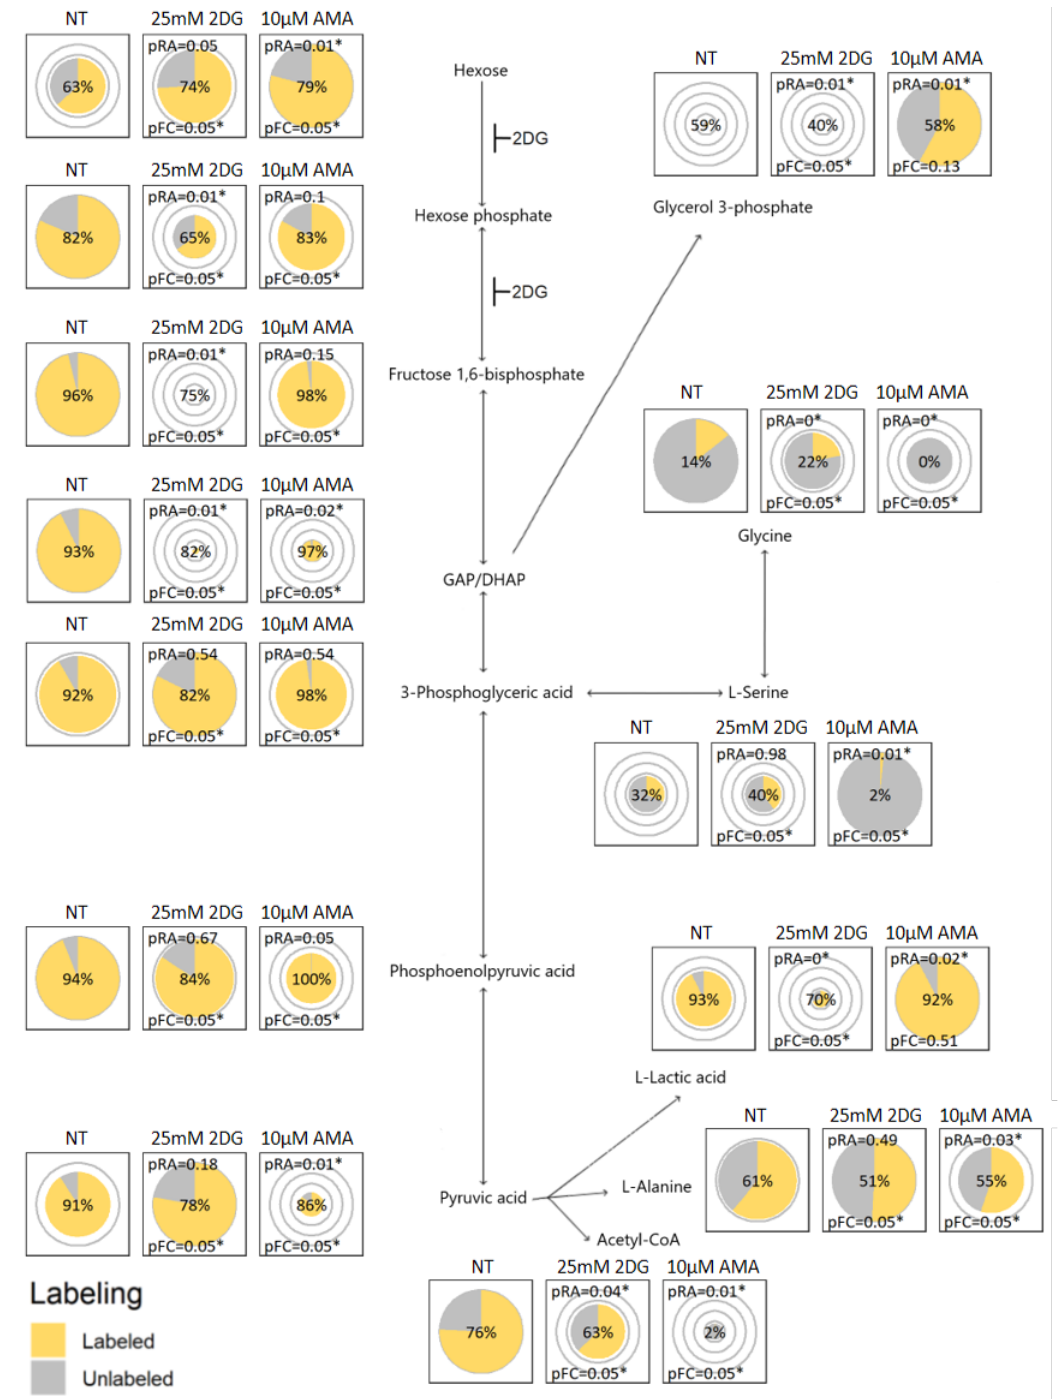
Figure 1. Visualizing tracer incorporation in glycolysis: Proposed pie chart visualizations by TraVis Pies plotted on a metabolic map of the metabolization of 13 C 6 -labelled glucose into glycolysis applied to three cohorts: non-treated (NT); 25 mM 2-deoxyglucose treated (2DG); or 10 µM antimycin A treated (AMA). For each metabolite, the pie radii correspond to the relative abundance which can be compared between the cohorts of this metabolite. Both the labeled surface fraction of the pie (yellow) and the percentage displayed in the middle of each pie reflect the fractional contribution. pRA and pFC indicate the significance of the difference in, respectively, the relative abundance or fractional contribution with the NT cohort. * indicates a p value ≤ 0.05. The details of the visualization are explained in more detail in the Methods section. GAP/DHAP: figure for either D-Glyceraldehyde 3-phosphate or Dihydroxyacetone phosphate, that are in equilibrium.